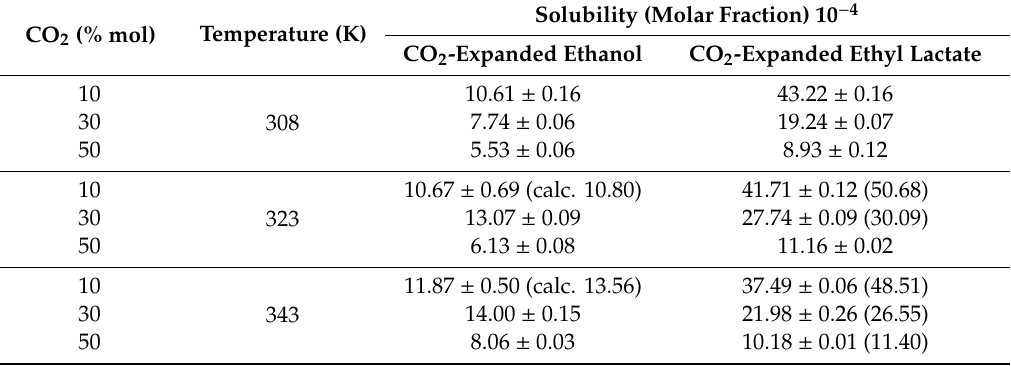
Table 2. Quercetin solubility in CO 2 -expanded ethanol and CO 2 -expanded ethyl lactate at 10 MPa. Solubility was also calculated using the first order kinetics constant when thermal degradation was observed (calculated values within parentheses). n =